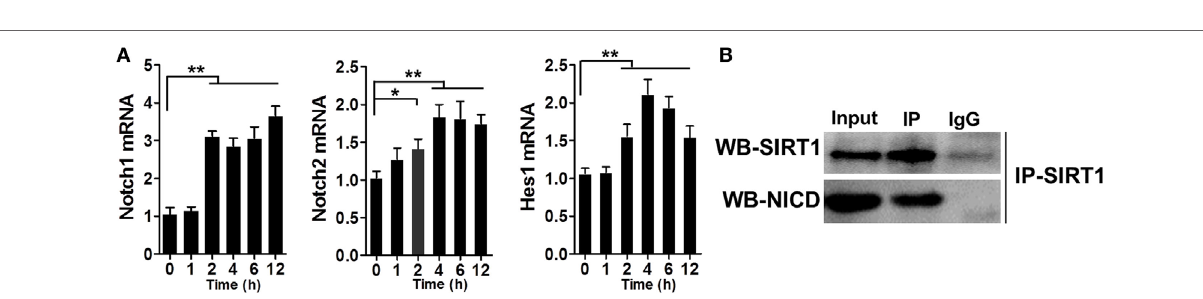
FigUre 5 | Direct interaction between Notch signaling and SIRT1 in macrophages. (a) RAW264.7 cells were treated with 1 µg/ml lipopolysaccharide (LPS), and then RT-PCR was used to examine the time-dependent expression of Notch1, Notch2, and Hes1. **p < 0.01 compared with 0 h; n = 6. (b) Co-immunoprecipitation of intracellular domain of Notch (NICD) and SIRT1. RAW264.7 cells were stimulated with LPS and then the cell extracts were used for immunoprecipitation (IP) with anti-NICD antibody and immunoblotting with anti-SIRT1 antibody, and for IP with anti-SIRT1 antibody and immunoblotting with anti-NICD antibody; n =